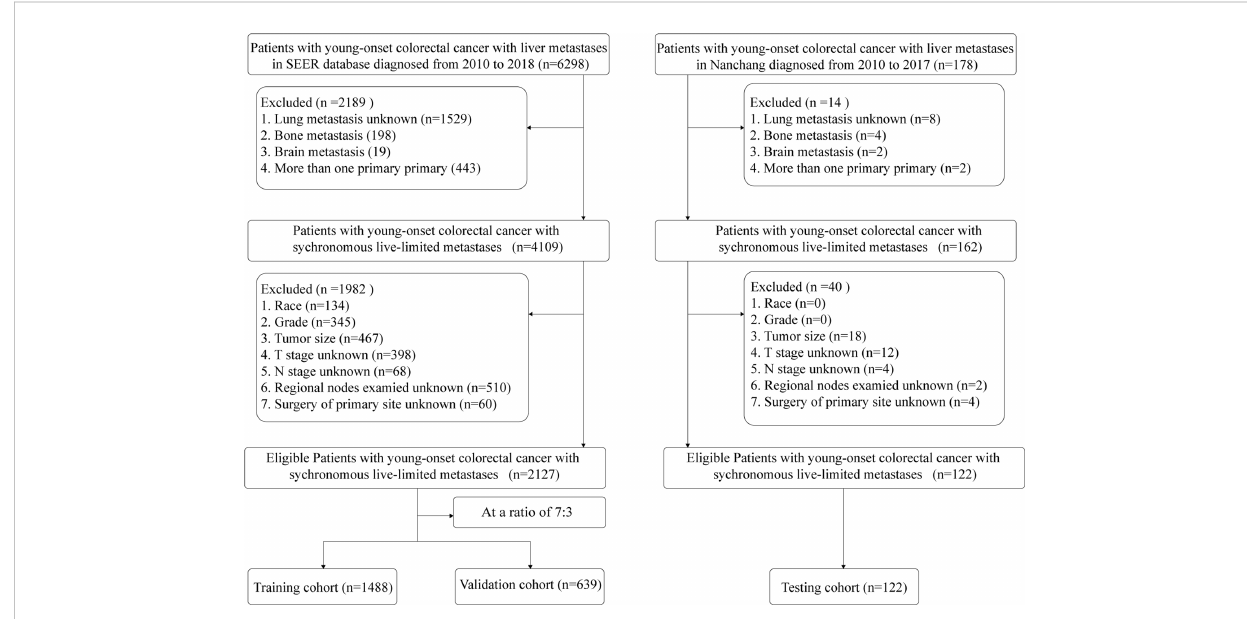
FIGURE 1 Flow chart for the selection of